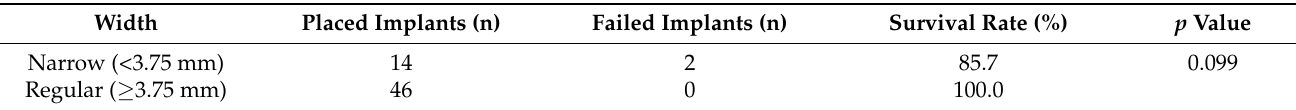
Table 4. Survival rate according to implant diameter.